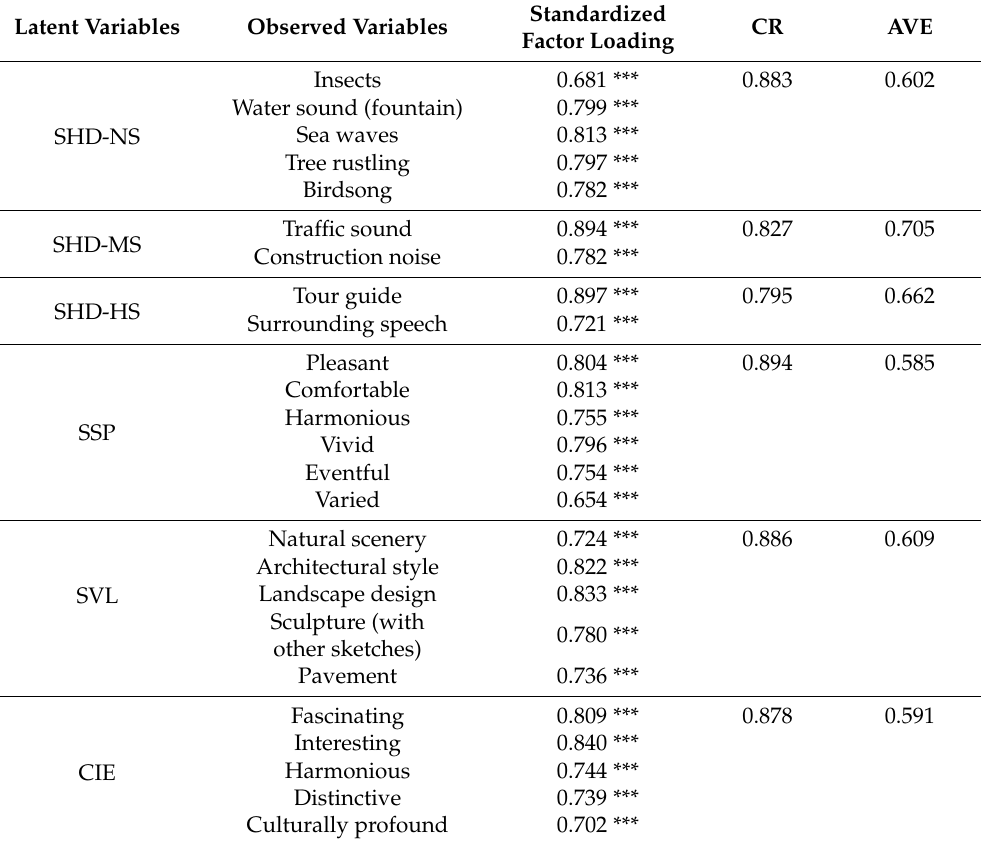
Table 4. Modified measurement model, SHD-NS: harmonious degree of natural sound,